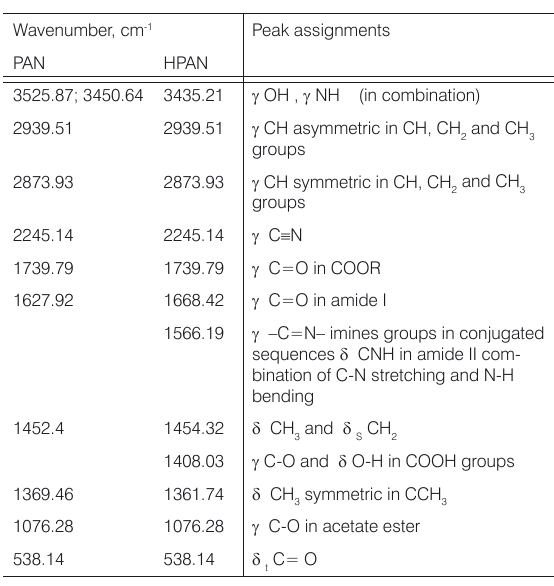
Figure 4. Schematic illustration of the PAN and HPAN Table 1. Analysis of FTIR spectra of PAN and HPAN samples.